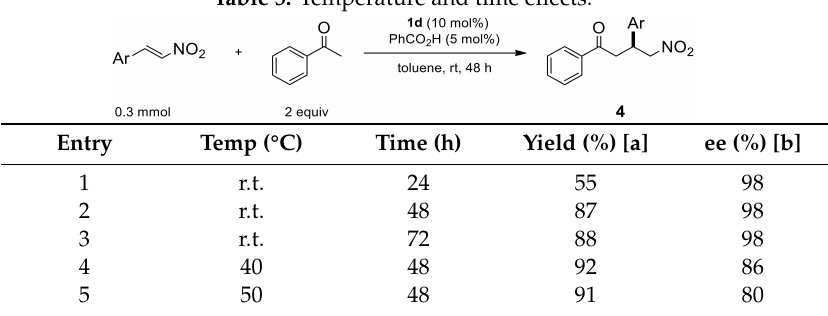
Table 5. Temperature and time e ff ects.